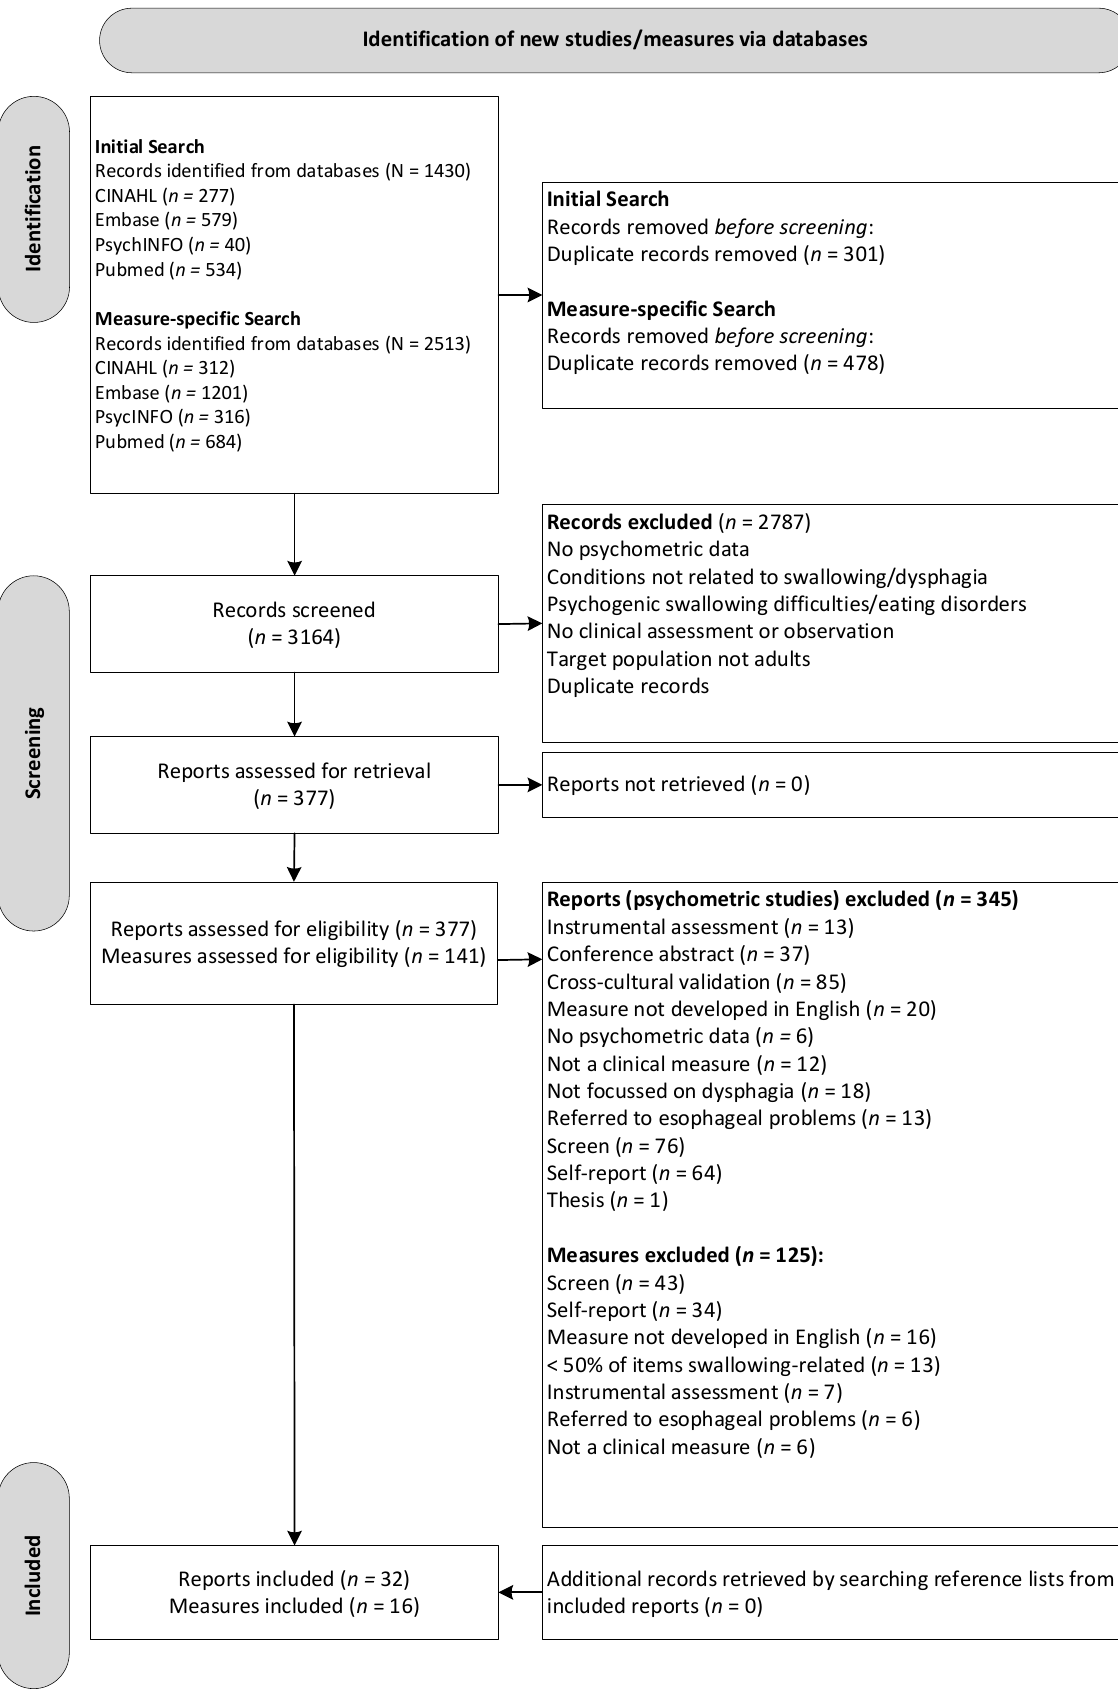
Figure 1. Flow diagram of the review process based on PRISMA.